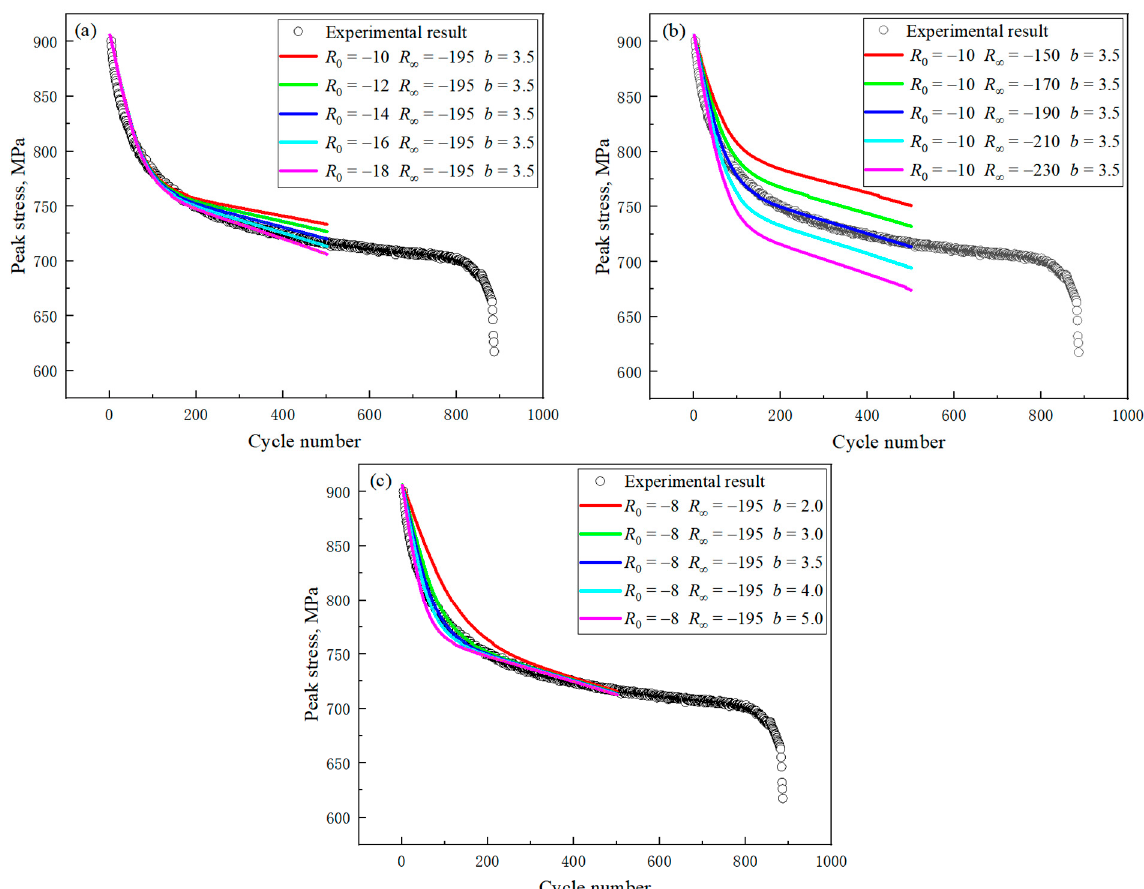
Figure 15. Results of sensitivity analysis for isotropic softening parameters: ( a ) R 0 ; ( b ) R ∞ ; ( c ) b.